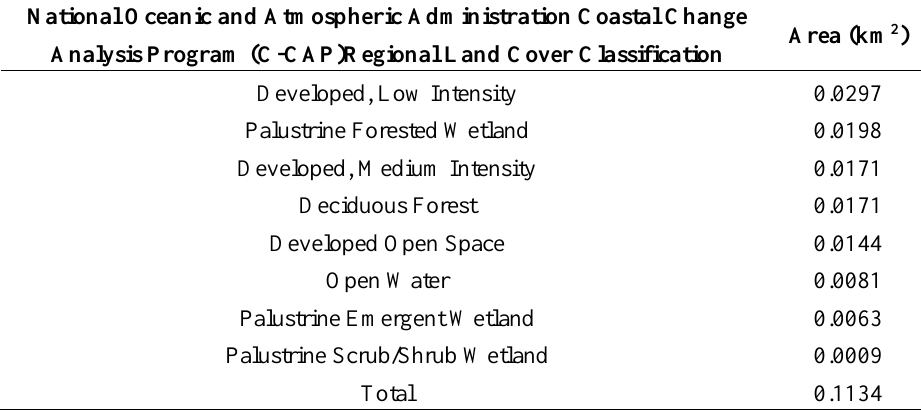
Table 2. National Oceanic and Atmospheric Administration, Office for Coastal Management, Coastal Change Analysis Program (C-CAP) Regional Land Cover data for inland areas in the study